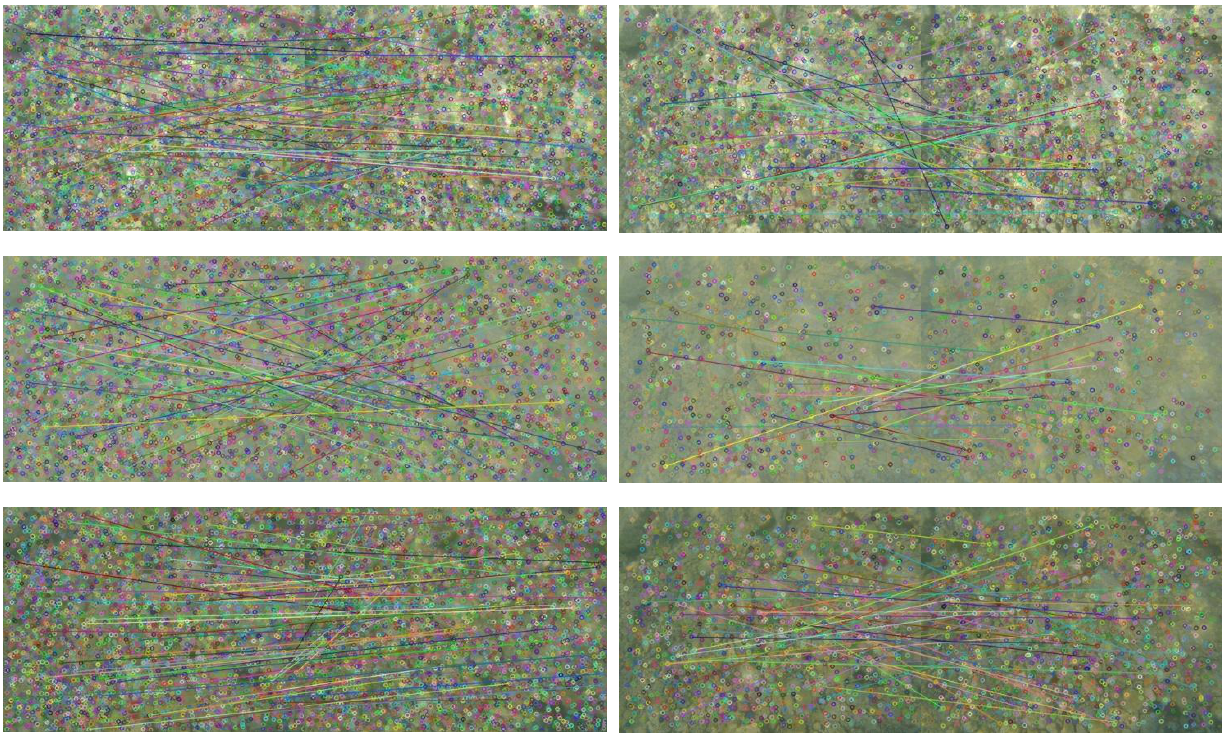
Figure 6. SIFT (left) and SURF (right) matched points on the original uncorrected imagery (first row), the corrected ct imagery (second row) and the corrected orig. imagery (third row) of the dataset 1.